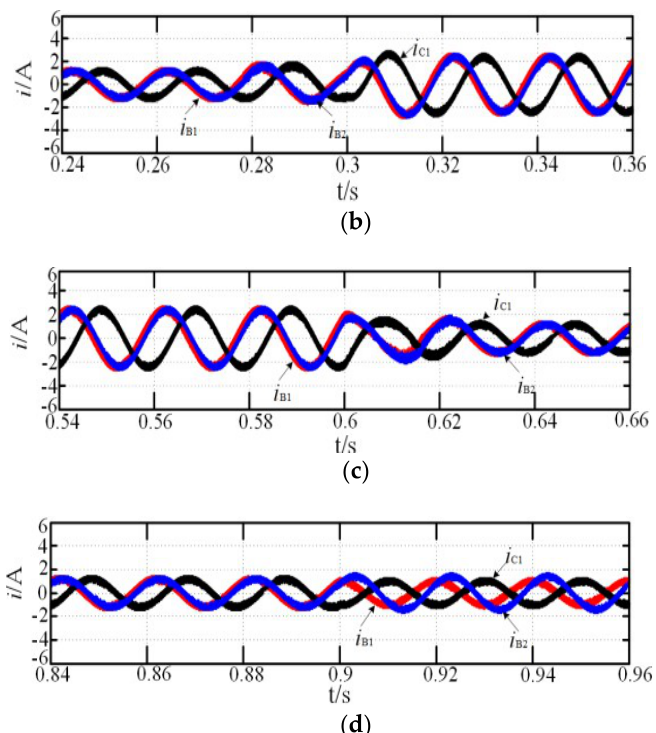
Figure 4. Start-up process simulation: ( a ) MCC; ( b ) magnification of M region; ( c ) magnification of N region; ( d ) magnification of P region.